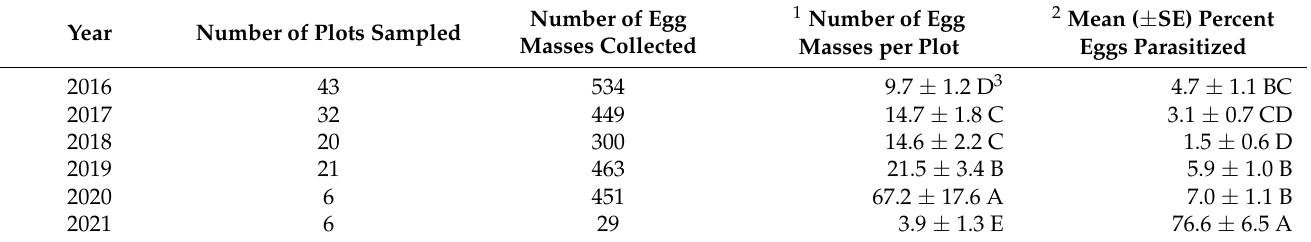
Table 1. Mean ( ± SE) percent squash bug eggs parasitized per year from 2016–2021.